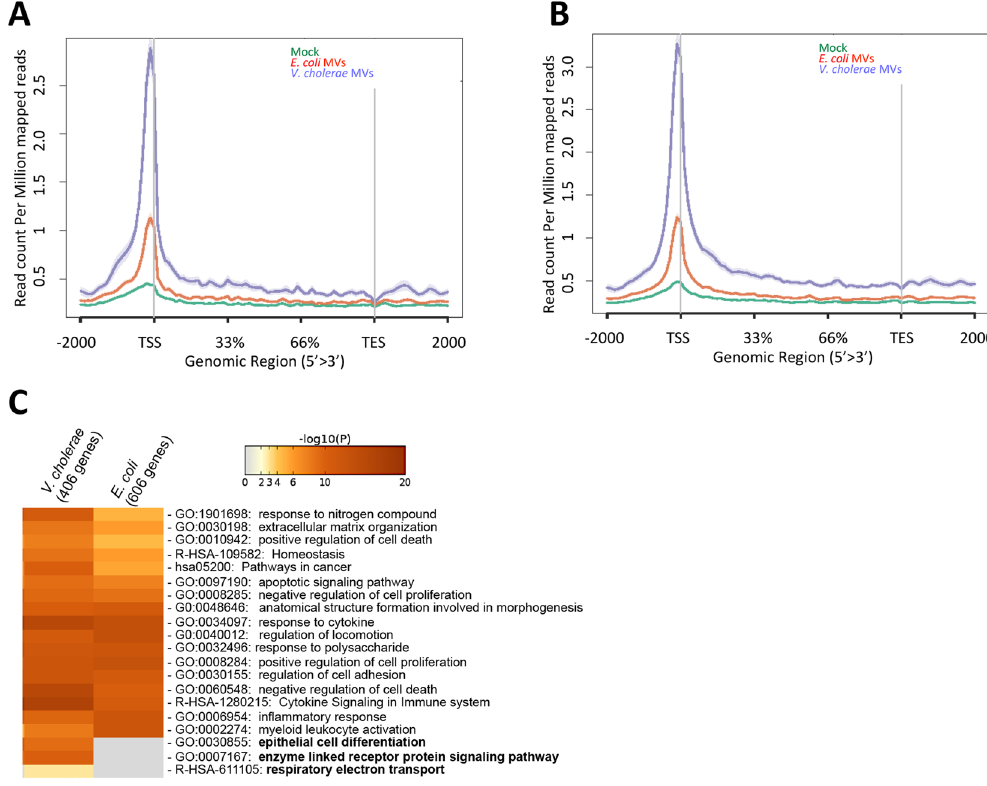
Figure 3. Influence of MVs on the opening of chromatin at promoters and TSS of upregulated gene transcripts in HCT8 colorectal cancer cell line. ( A ) FAIRE signal (nucleosome free-DNA) at TSS of upregulated genes (465 genes) in HCT8 cells co-cultured with MVs from V. cholerae . ( B ) FAIRE signal at TSS of upregulated genes (738 genes) in HCT8 cells co-cultured with MVs from E. coli . ( C ) GO enriched terms of genes upregulated and with FAIRE signal in HCT8 cells co-cultured with MVs from E. coli or V. cholerae